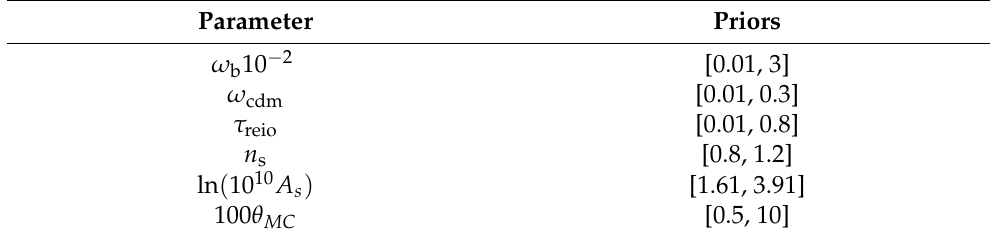
Table 2. Marginalized constrains on the cosmological parameters (mean values) from GetDist at 68% limits of MCMC chains of each model. The χ 2